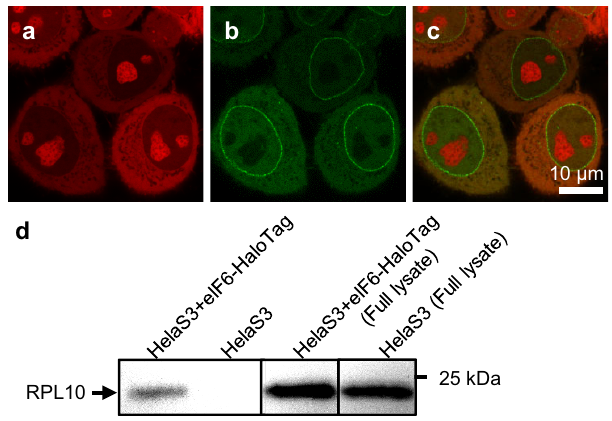
Fig. 1 HeLa S3 cells expressing eGFP-NTF2 (green) and eIF6-HaloTag (red). a eIF6-HaloTag-JF549 staining. b eGFP-NTF2. c Overlay of both channels. d Immunoblotting against Rpl10 after pulldown of eIF6-HaloTag in HeLa S3 cells stably expressing eIF6-HaloTag and untreated HeLa S3 cells. Loading controls are shown on the right-hand